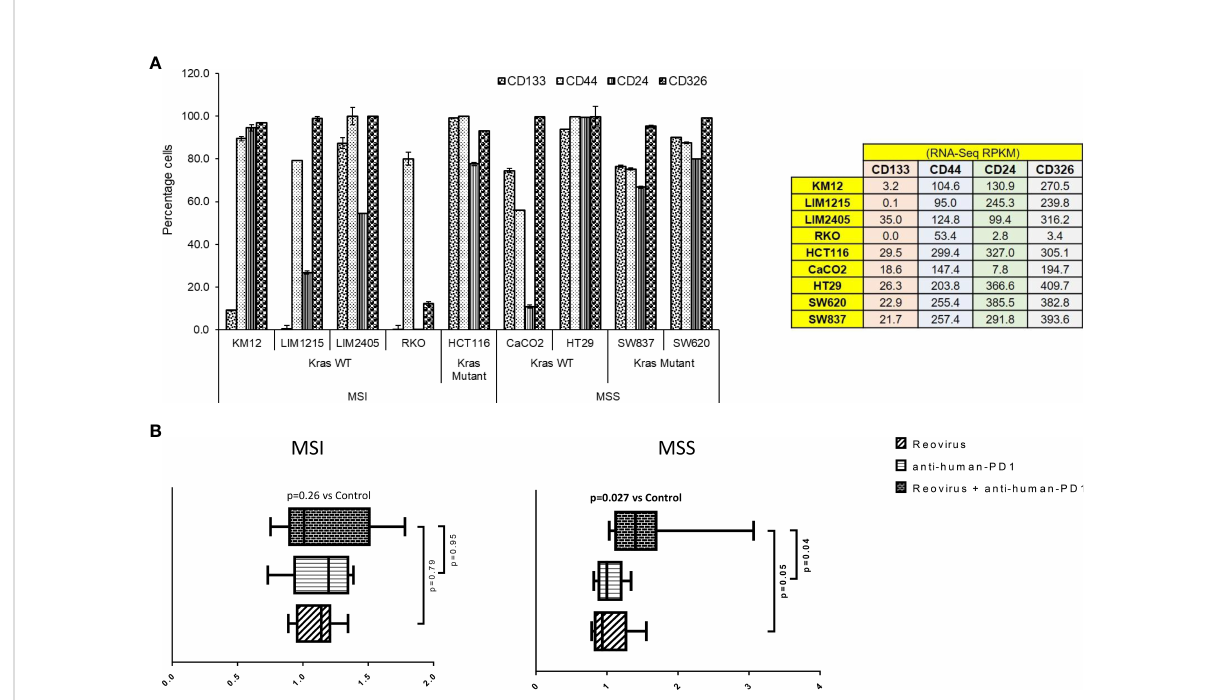
FIGURE 3 Selection of CRC cell lines, measurement of cytotoxicity, live-cell imaging and analysis in an ex vivo co-culture system. (A) Human CRC cell lines were selected based on expression of epithelial and stemness markers, and sensitivity towards reovirus infection. Out of 59 CRC cell lines screened using RNA-Seq (Supplementary Figure 2), nine highly expressing ones (values are indicated on right panel table) with increased sensitivity to reovirus (Figure 1A and Supplementary Figure 1) were chosen and subjected to con fi rmatory analyses. One cell line per condition based on statuses of MMR and KRAS mutation with top expression of epithelial and stemness markers was taken for ex vivo co-culture studies (n=8). (B) Levels of cell death among MSI and MSS CRC cell lines co-cultured with human PBMC (1:5) and treated with reovirus, anti-human PD-1 and their combination. Trends in fold difference and signi fi cance are depicted on box and whisker plot. Combination treatment compared to placebo rendered signi fi cant improvement in cell death only in MSS group. Combo increased cell death 1.6-fold in MSS and 1.2-fold in MSI (p values in bold letters indicate signi fi cance). Single agent treatments resulted in more than 1-fold cell death in all groups. Details of cell death was captured using live-cell imaging system and provided under Supplementary Movie